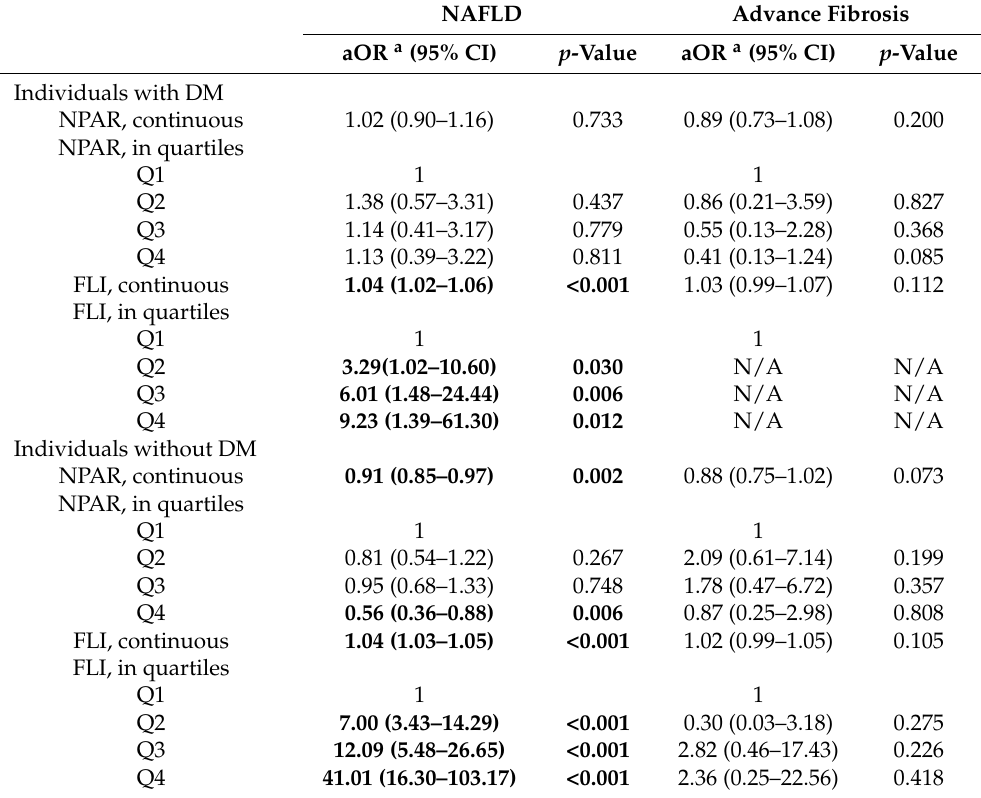
Table 3. Associations between NPAR, FLI, and presence of NAFLD and advanced fibrosis stratified by DM